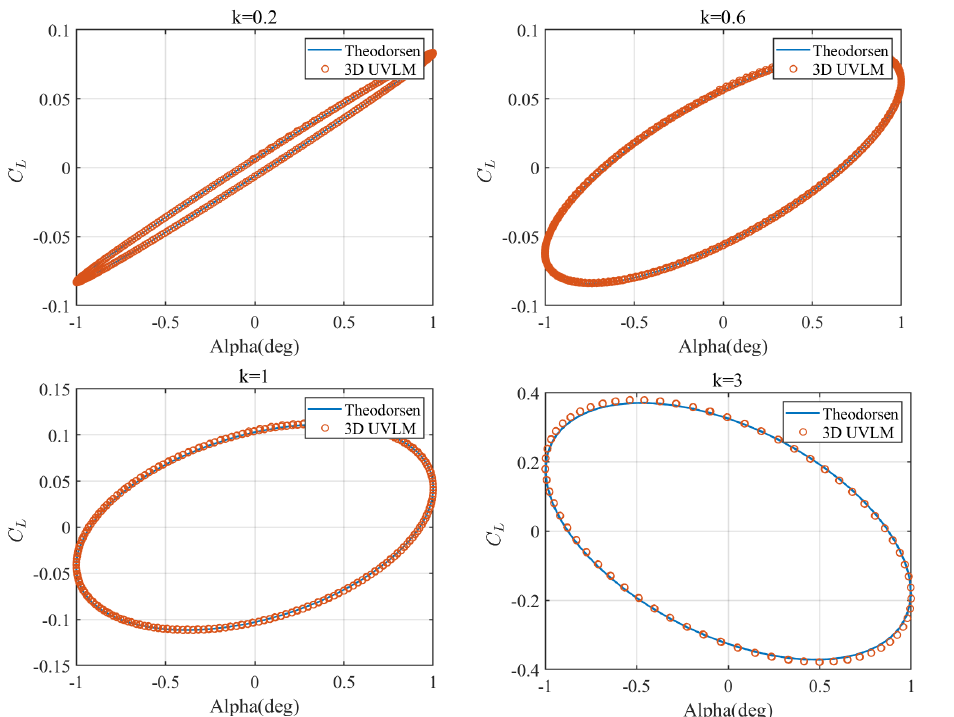
Figure 10. Diagrams of lifting coefficient C L for pitch oscillations at different reduced frequencies.